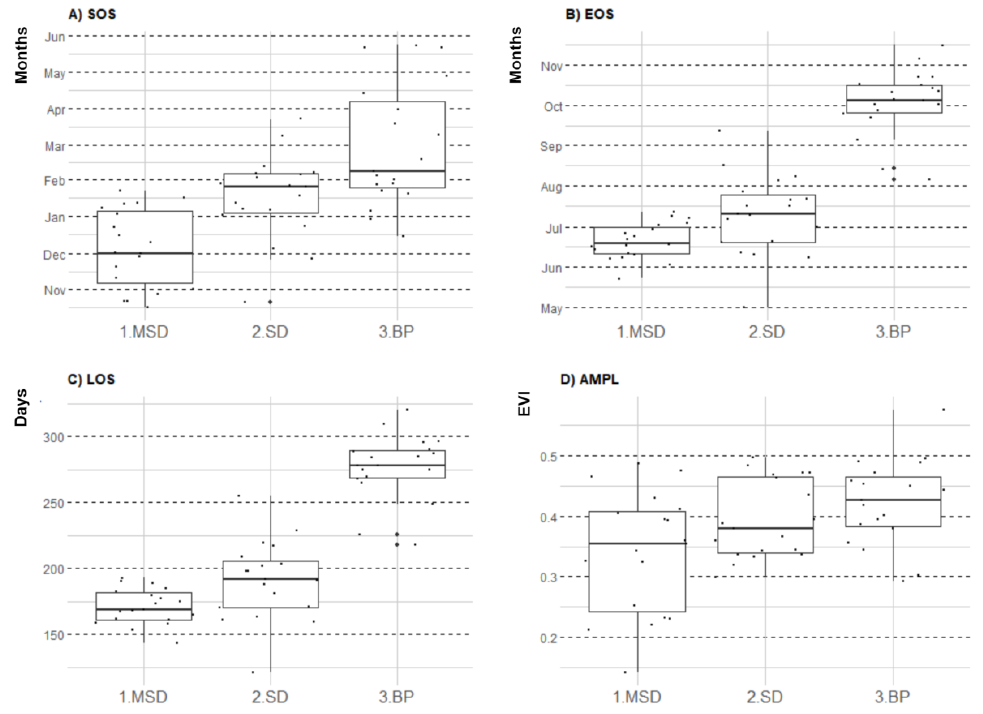
Figure 3. Caatinga phenological metrics of the three ecoregions studied, ( A ) SOS, ( B ) EOS, ( C ) LOS, and ( D ) Amplitude.